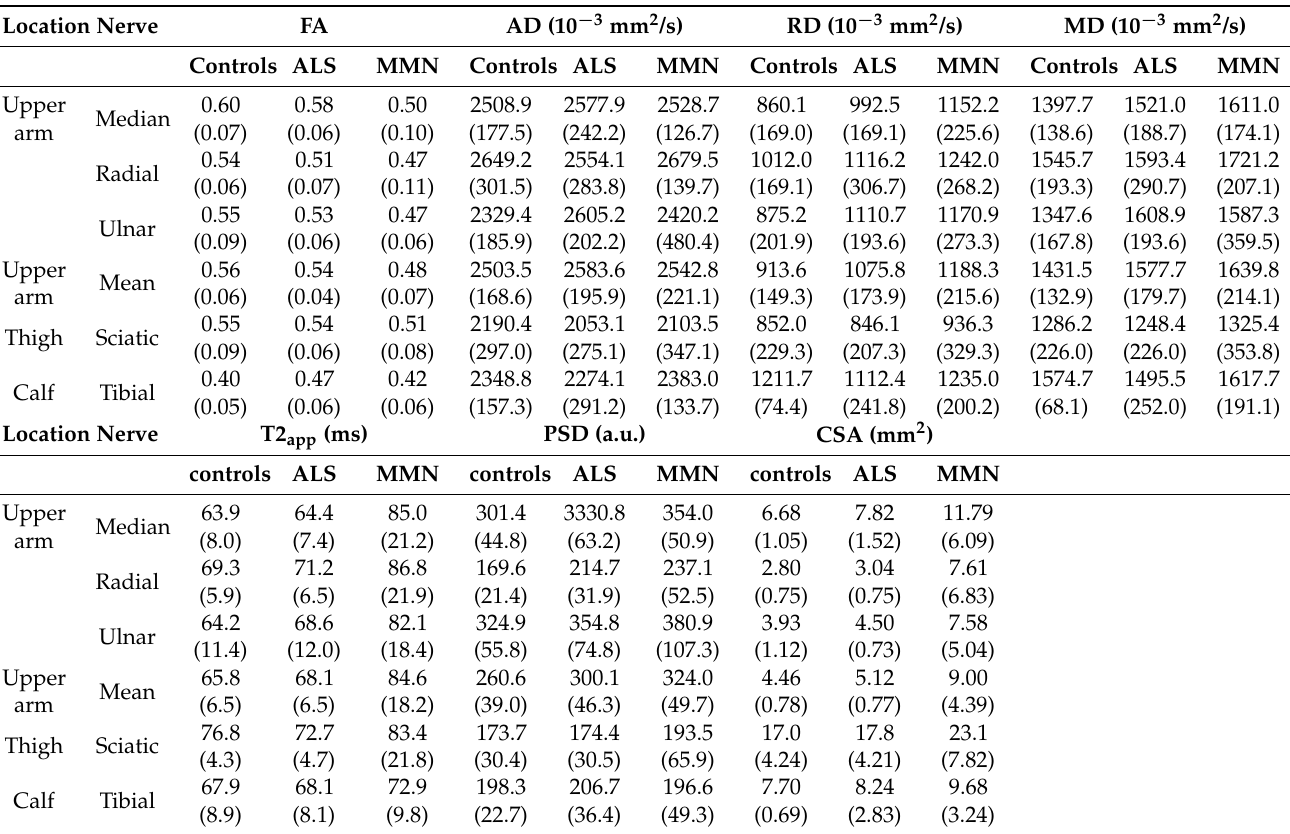
Table A2. Parameters of DTI, T2 relaxometry, and CSA per nerve and region. Values are mean